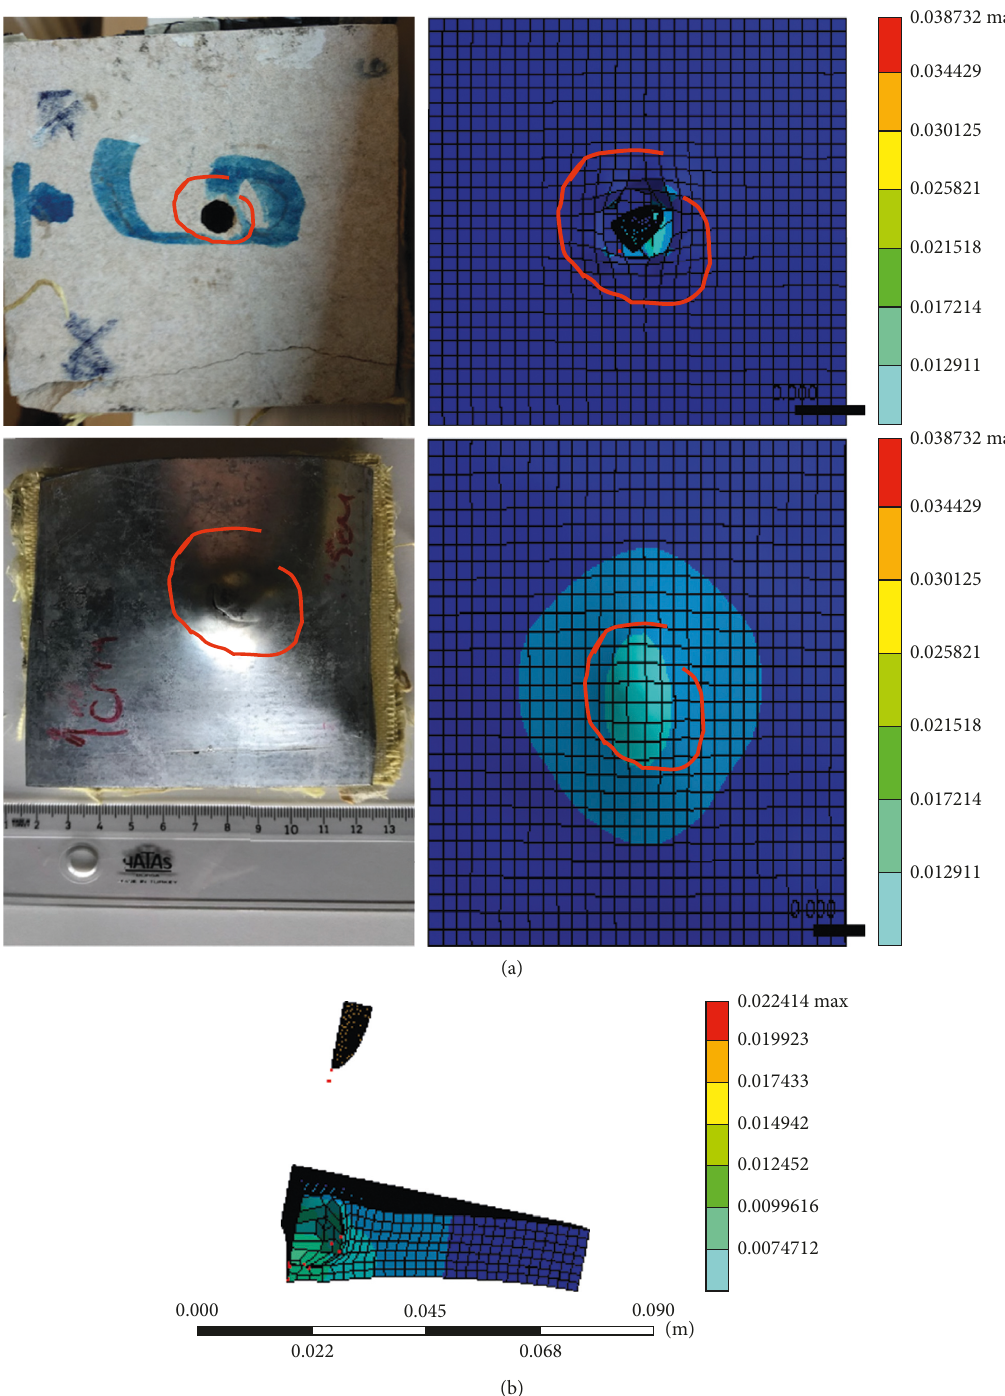
Figure 9: (a) Total deformation of sample 2 as shown in experimental and simulation conditions. (b) 3D cross section of total deformation of sample 2 and the 9 mm FMJ